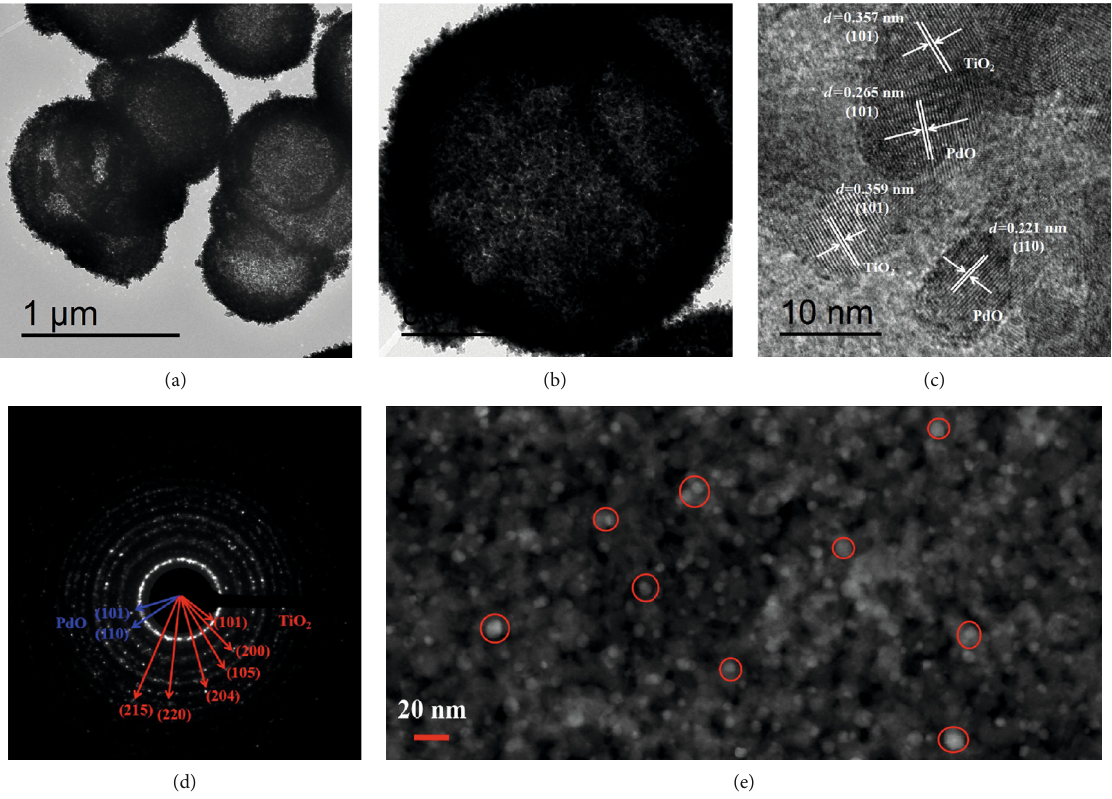
, (b)TiO -T, (c)TiO 2 2